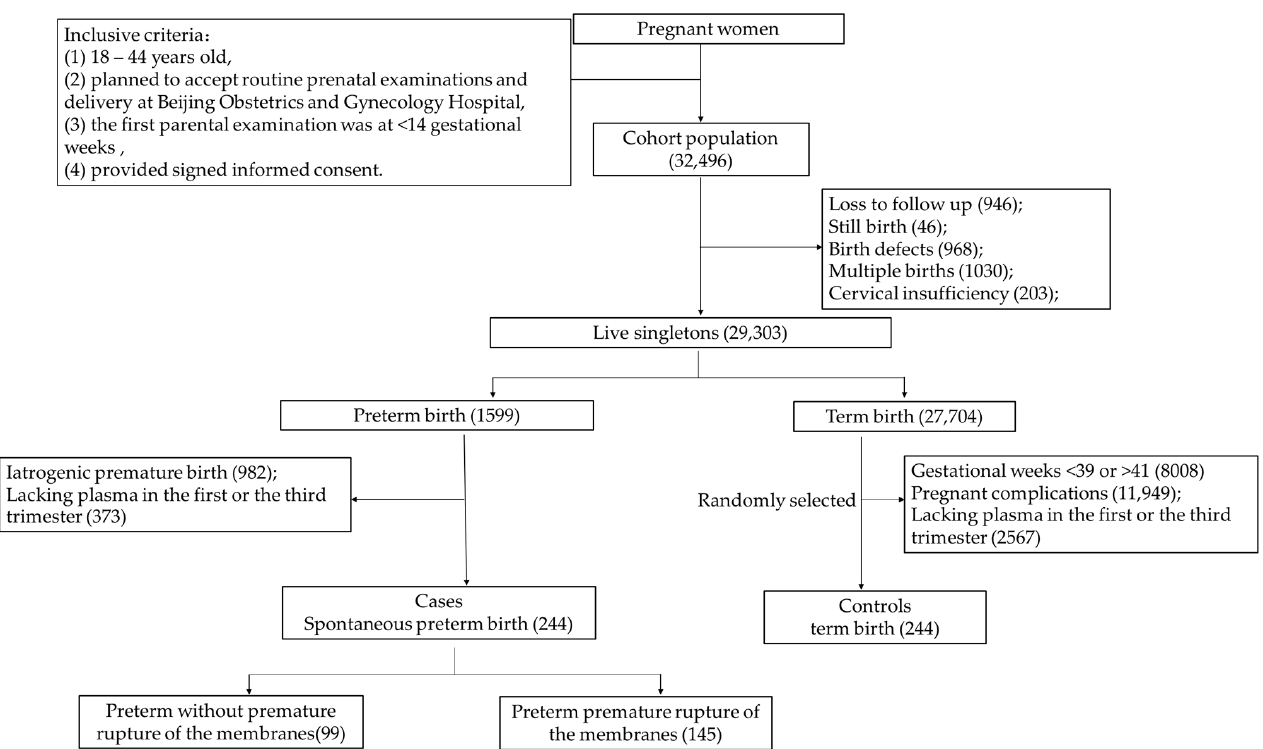
Figure 1. Flow diagram of the selection of cases and controls from the cohort.